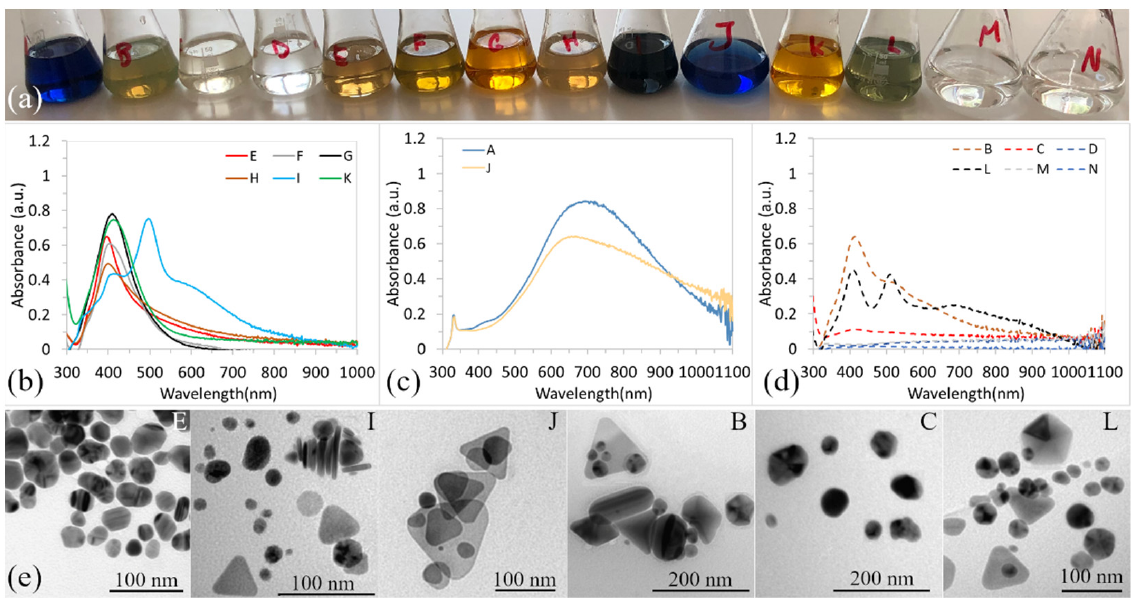
Figure 2. The AgNPs coloids of different color on 7th day of experiment ( a ); UV-vis of the first group of solution (yelow—E, F, G, H, I, K) ( b ); the second group (blue—A, J) ( c ); the third group ( d ) and the TEM images of AgNPs of colloidal solutions E, I, J, B, C and L (from left to right ) ( e ).